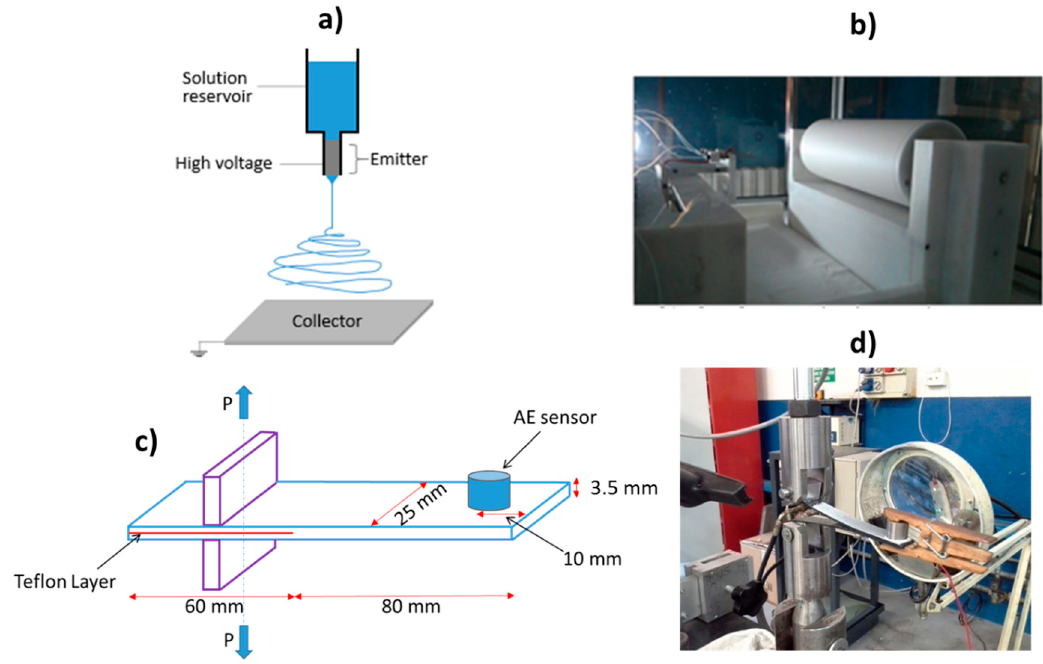
Figure 1. Electrospinning and testing equipment: ( a ) schematic of the electrospinning process; ( b ) the electrospinning equipment; ( c ) scheme of the experiment; ( d ) specimens and experimental setup.